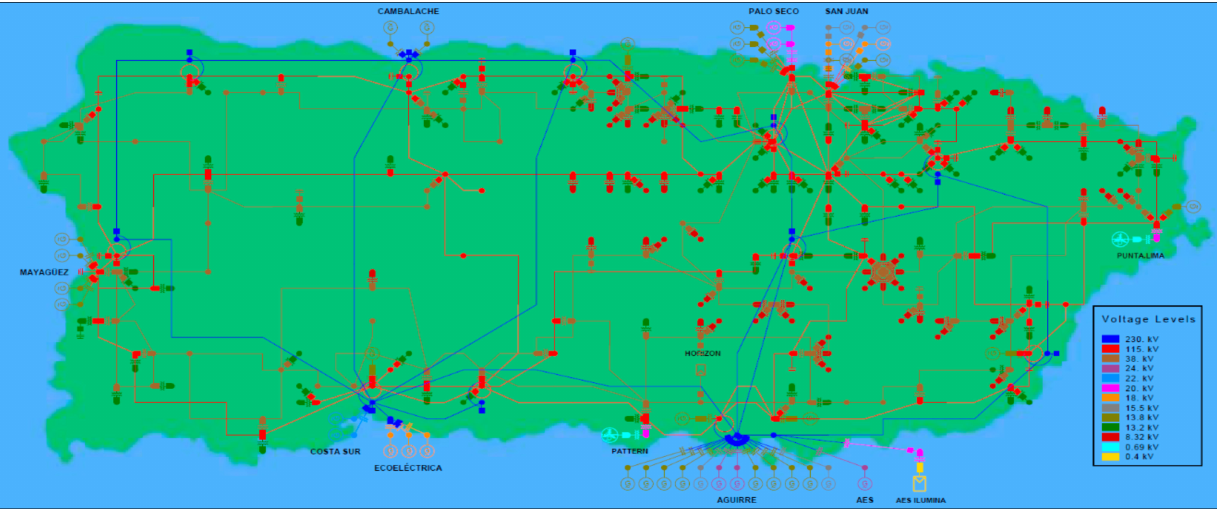
Figure 8. One-line diagram of the Puerto Rico electric power system (230 kV—blue; 115 kV—red; 38 kV—brown; 13.2 kV— green; 8.32